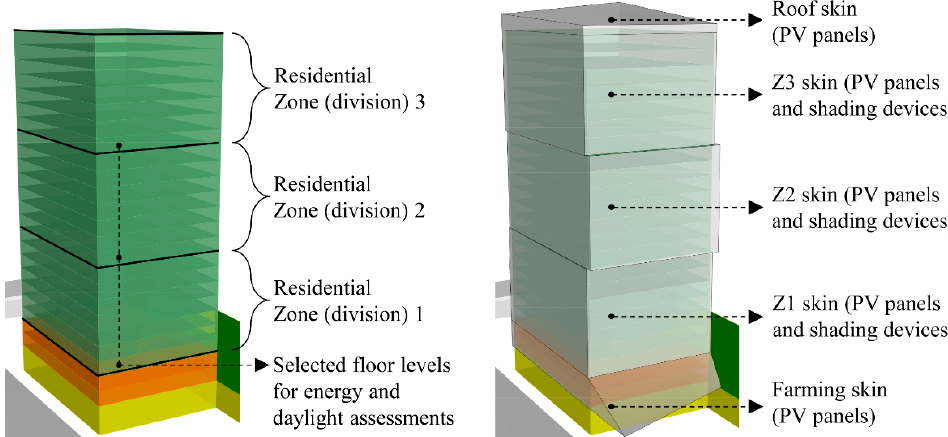
Figure 4. Proposed façade design and building zones (subdivisions).